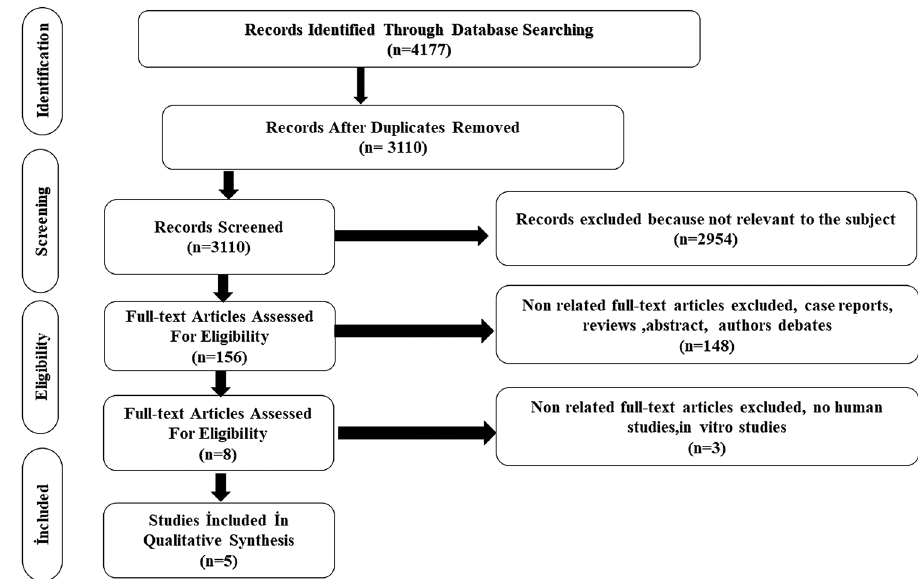
Figure 1. The PRISMA Flow Chart shows the process for article